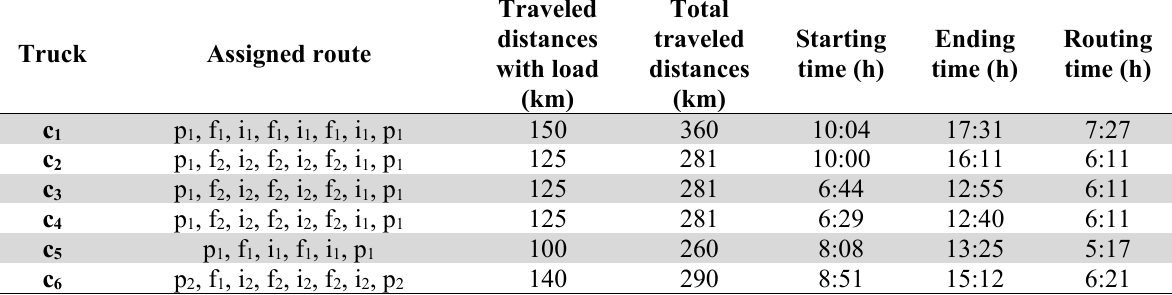
Table 5 Routes generated through the [H] algorithm Truck Assigned route